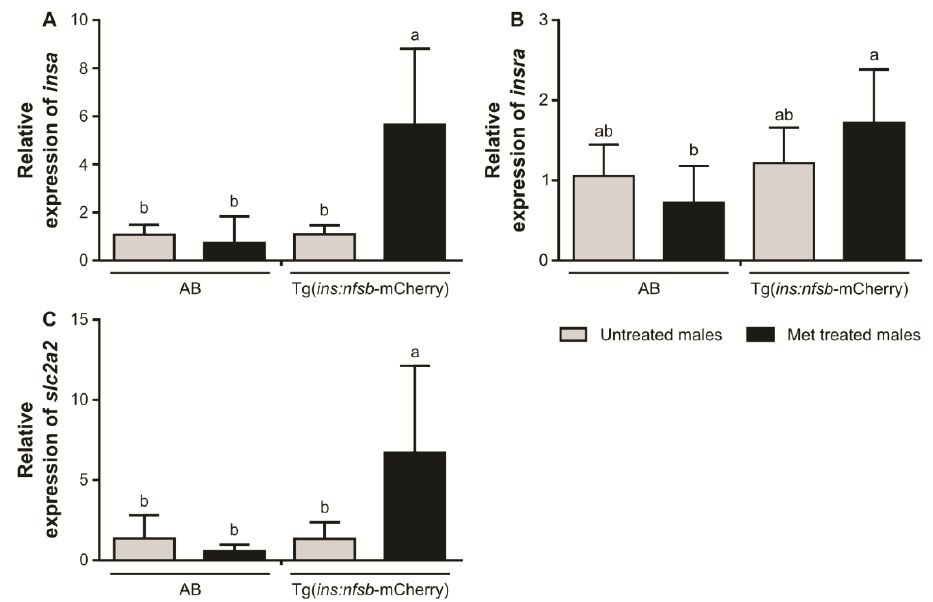
Figure 2. Gene expression of insulin metabolism markers in zebrafish sperm pools: ( A ) expression of insa in spermatozoa pools from AB males in control ( n = 4) and metronidazole (Met) treatment ( n = 4) groups and Tg( ins : nfsb-mCherry ) in control ( n = 5) and Met treatment ( n = 7) groups; ( B ) expression of insra in spermatozoa pools from AB males in control ( n = 4) and Met treatment ( n = 4) groups and Tg( ins : nfsb-mCherry ) in control ( n = 7) and Met treatment ( n = 7) groups; ( C ) expression of slc2a2 in spermatozoa pools from AB males in control ( n = 4) and Met treatment ( n = 4) groups and Tg( ins : nfsb-mCherry ) in control ( n = 5) and Met treatment ( n = 6) groups. The plotted values represent means ± SD. Different letters represent statistical differences (one-way ANOVA, post hoc SNK, p < 0.05).